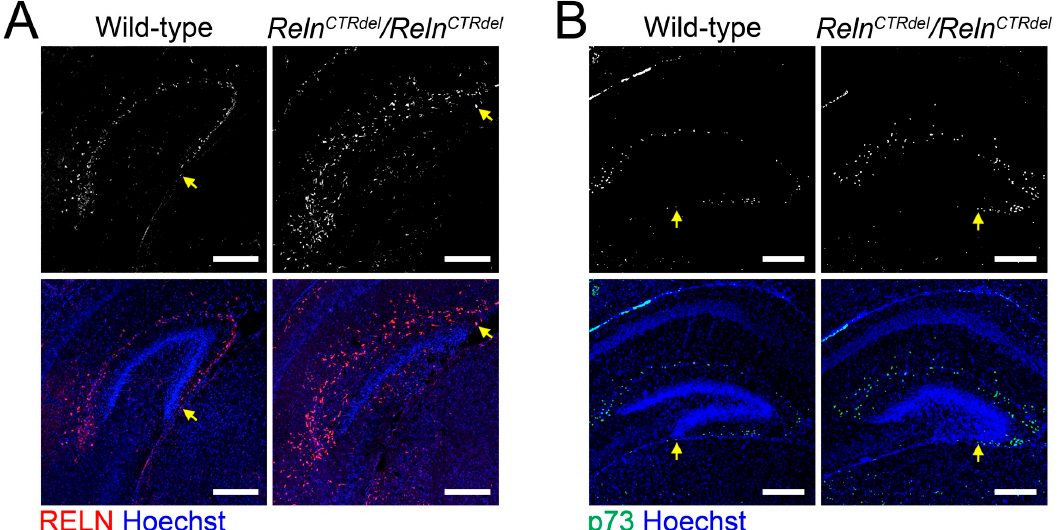
Figure 1. Lack of the Cajal-Retzius cells in the infrapyramidal blade. ( A ) The infrapyramidal blade (IPB) of dentate gyrus does not develop in Reln CTRdel , and this coincides with the absence of the RELN-positive cells (gray or red) in the prospective infrapyramidal blade. P7 brains were immunostained with anti-RELN antibodies ( n = 2 each). ( B ) Distribution of p73-expressing cells (gray or green) in the dentate gyrus at P7 ( n = 2 each). The number of p73-expressing cells is increased in the suprapyramidal blade (SPB). Nuclei were stained using Hoechst (blue). Scale bars, 250 µm. Arrows indicate the edge of Cajal-Retzius cell-containing regions, which are near the fimbrodentate junction (in the wild type) or the tip of truncated IPB (in the mutants).